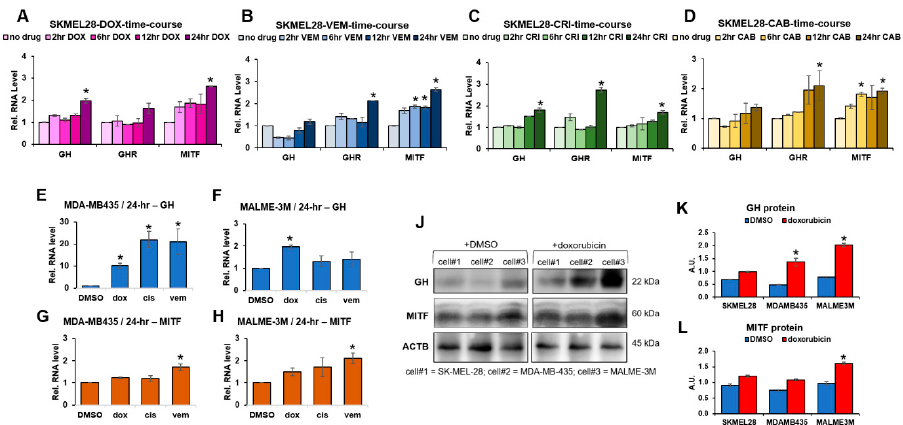
Figure 1. Changes in gene expression following drug-treatment in human melanoma cells: ( A – D ) Human melanoma cells SK-MEL-28 were treated with anticancer drugs and RNA expression was compared with respective untreated controls, at 2, 6, 12, and 24 h timepoints by RT-qPCR with corresponding prevalidated primers (sequence in supplementary Table S1) for target genes. Changes in growth hormone (GH), growth hormone receptor (GHR), and melanocyte-inducing transcription factor (MITF) and ABC-transporters (supplementary Figure S1A–D) with time due to doxorubicin ( A ), vemurafenib ( B ), crizotinib ( C ), and cabozantinib ( D ) treatments reflected concomitant changes in MITF, GH–GHR axis ( A – D ) as well as in ABC-transporters (Supplementary Figure S1A–D). ( E – H ) Changes in RNA expressions of GH ( E , F ) and MITF ( G , H ) RNA expressions at 24 h treatment with doxorubicin (dox), or cisplatin (cis), or vemurafenib (vem) treatments on MDA-MB-435 ( E , G ) and MALME-3M ( F , H ) cells. RNA expressions were quantified by RT-qPCR and normalized against expression of TUBB5 and ACTB as reference genes (*, p < 0.05, Wilcoxon sign rank test, n = 3). ( J – L ) In SK-MEL-28, MDA-MB-435, and MALME-3M human melanoma cells, treatment with doxorubicin for 48 h increased the protein levels of GH and MITF as seen by western-blot ( J ) and subsequent quantification using ImageJ (NIH) ( K , L ) and expressions were normalized against expression of ACTB ( β -actin) (*, p < 0.05, Students t test, n =